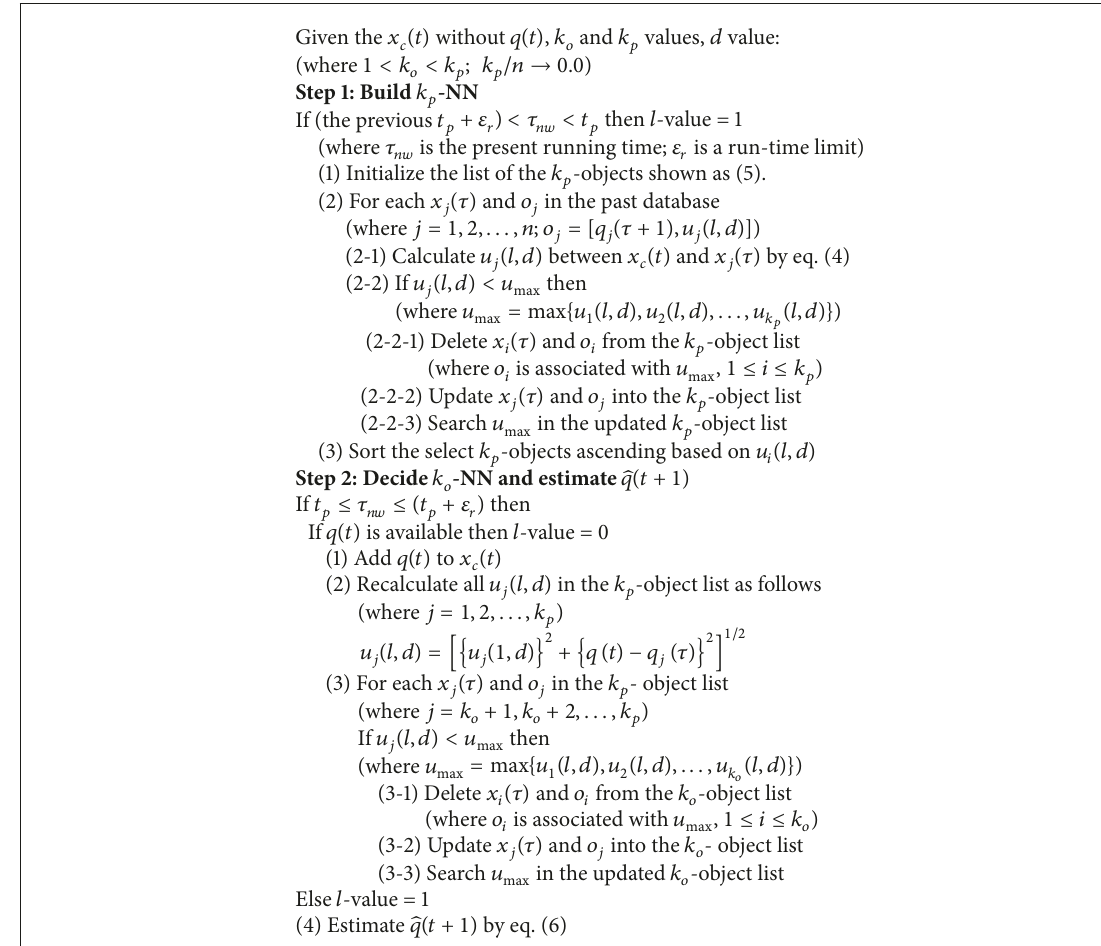
Algorithm 1: Pseudocode for the KNN-S2S prediction